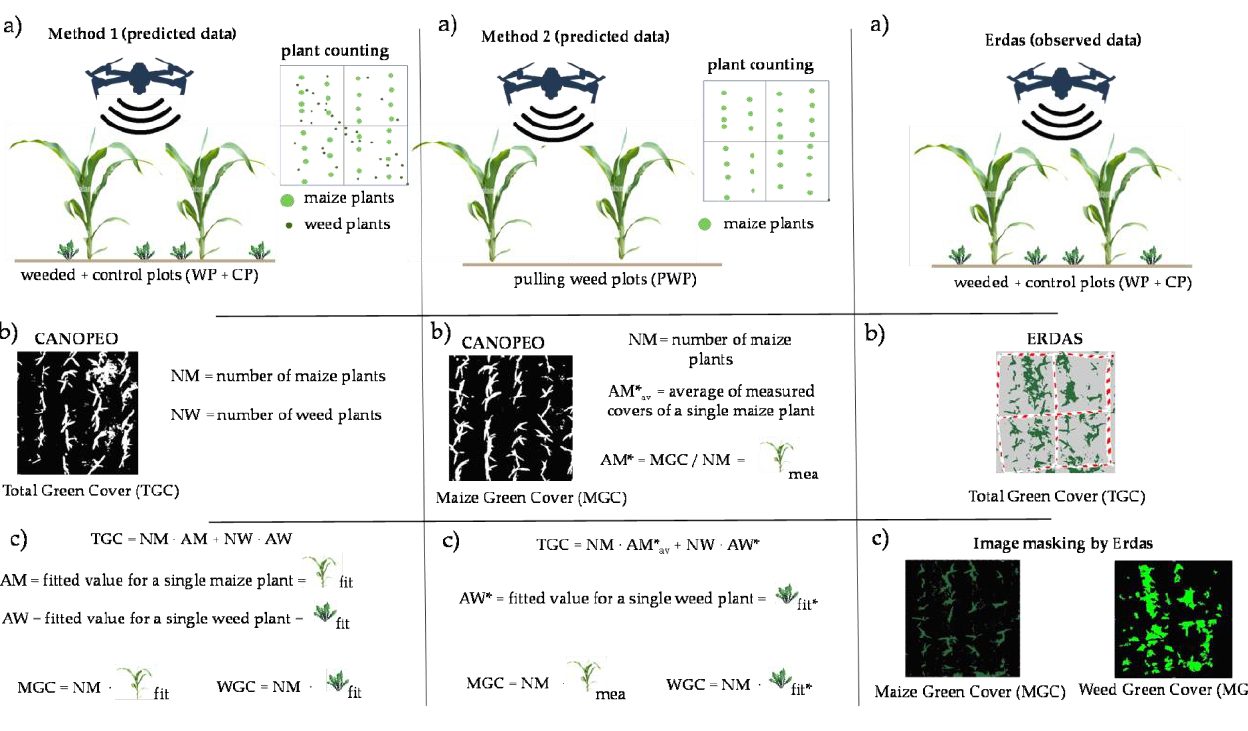
Figure 2. The graphic summary of the maize and weed green cover (MGC and WGC) from the two estimation methods (predicted data) in comparison to the Erdas classification method (observed data) (( a ) = collection data, ( b ) = processing data, ( c ) = fitting and results, (*) = values used for the method 2).